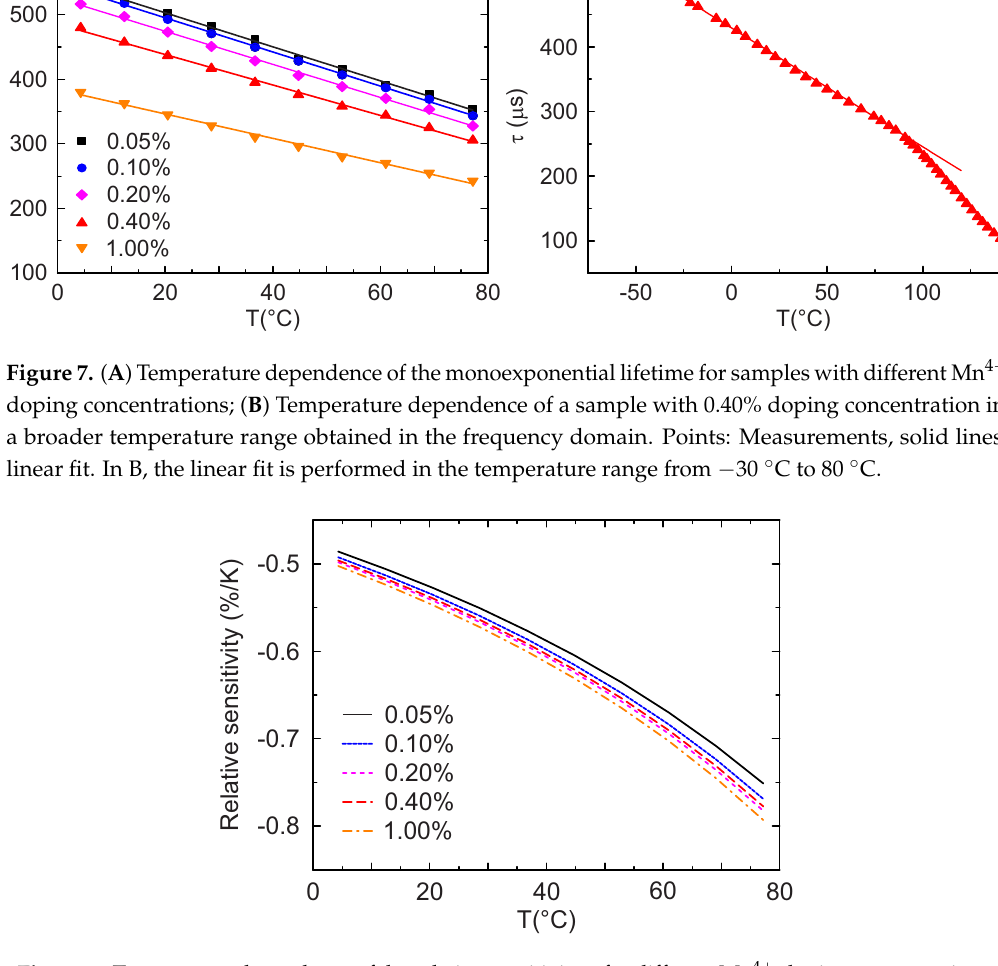
Figure 8. Temperature dependence of the relative sensitivity s for different Mn 4 + doping